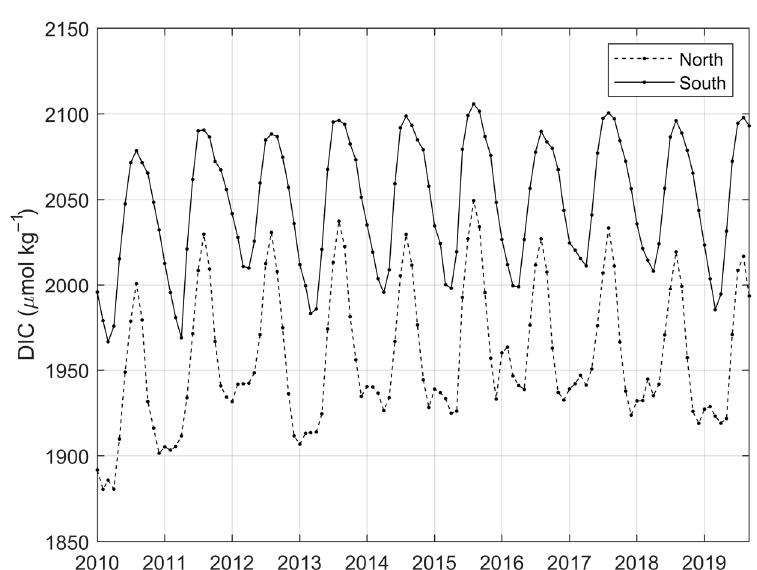
Figure 9. Monthly DIC determined from the MLR using satellite SST and SSS for the region north and south of the equator between January 2010 and September 2019.